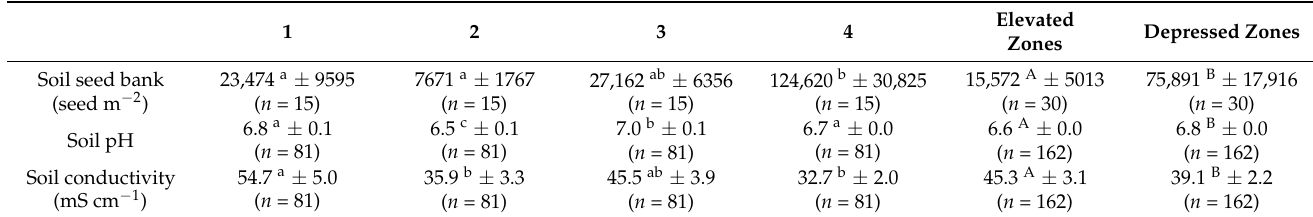
Table 1. Sediment pH and electrical conductivity (EC) (mS cm − 1 ) and seed-bank density (seed m − 2 ) for four populations of Salicornia ramosissima , and in elevated and depressed zones. Different letters indicate significant differences among populations (Kruskal–Wallis test, p < 0.05) or between elevated and depressed zones (Mann–Whitney test, p < 0.05). Data are mean ± SE. Elevated Depressed Zones